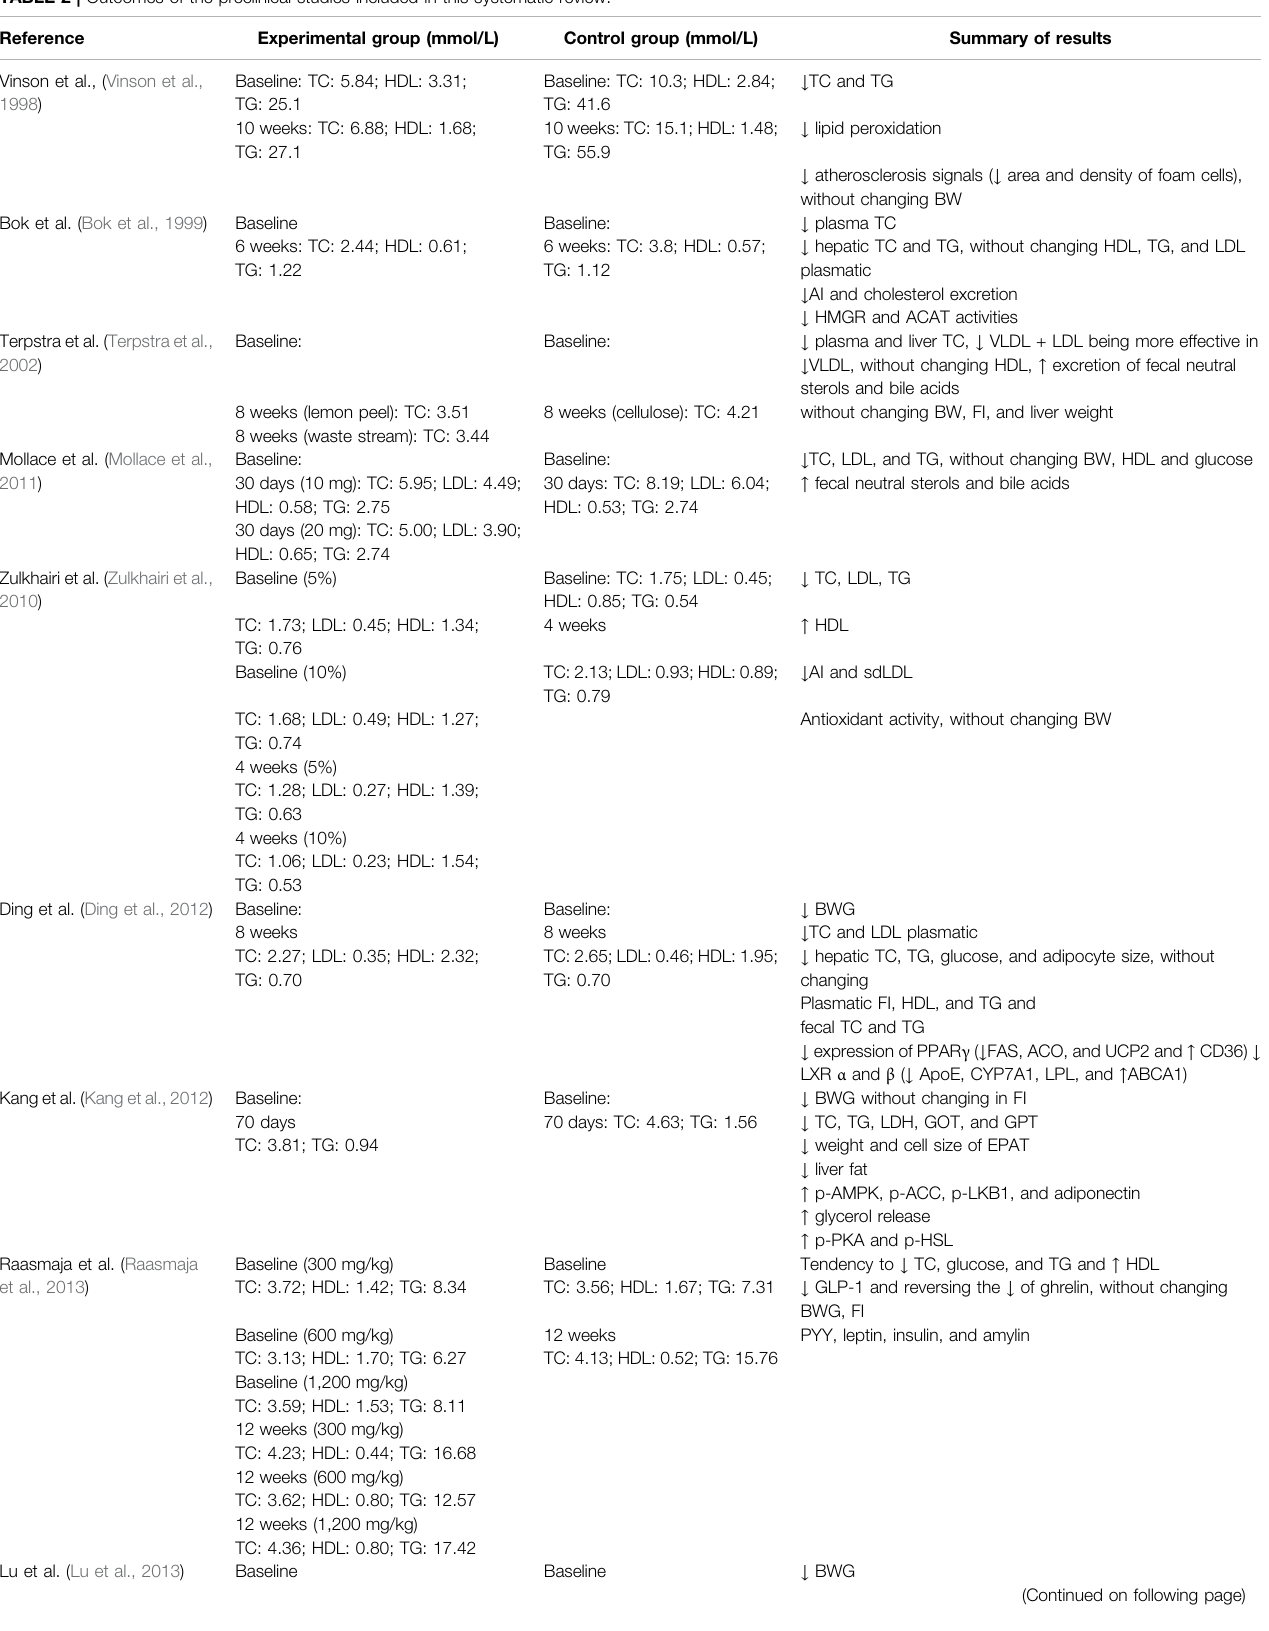
TABLE 2 | Outcomes of the preclinical studies included in this systematic